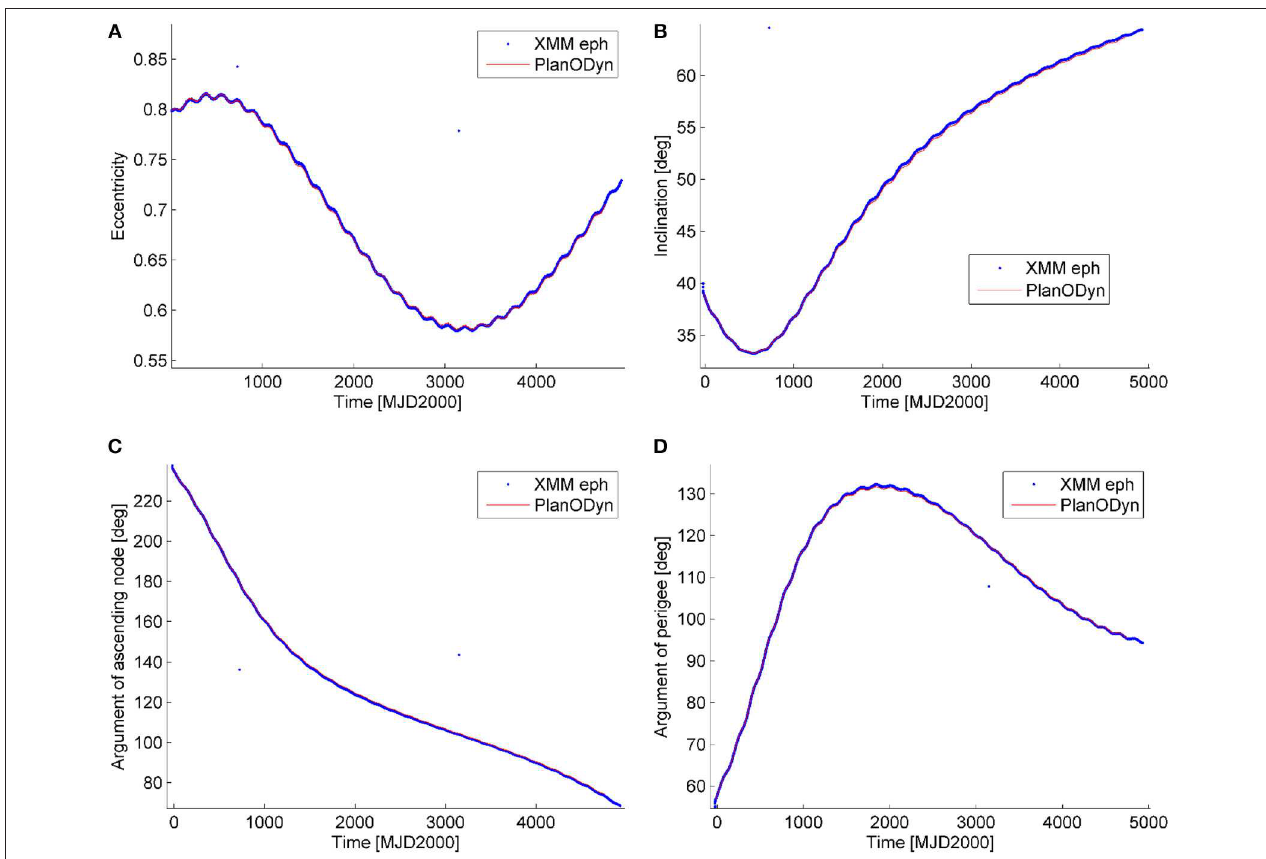
FIGURE 2 | XMM Newton’s ephemerides: actual ephemerides in blue and propagation with PlanODyn in red. (A) Eccentricity, (B) inclination, (C) argument of the ascending node, and (D) argument of the perigee. The x-axis represents the time in Modified Julian Date since 2000 (Time origin at 12:00 year 2000).